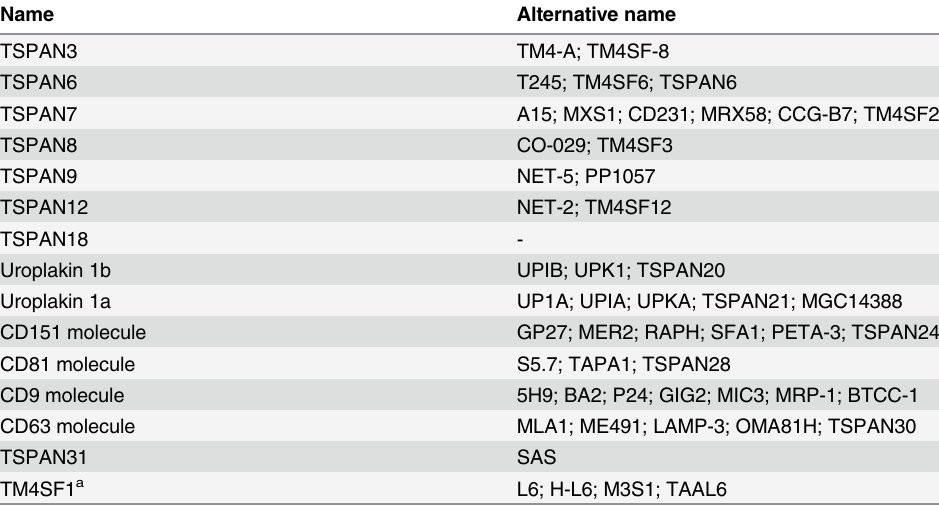
Table 2. Human tetraspanin superfamily members used for expression screening in S . cerevisiae